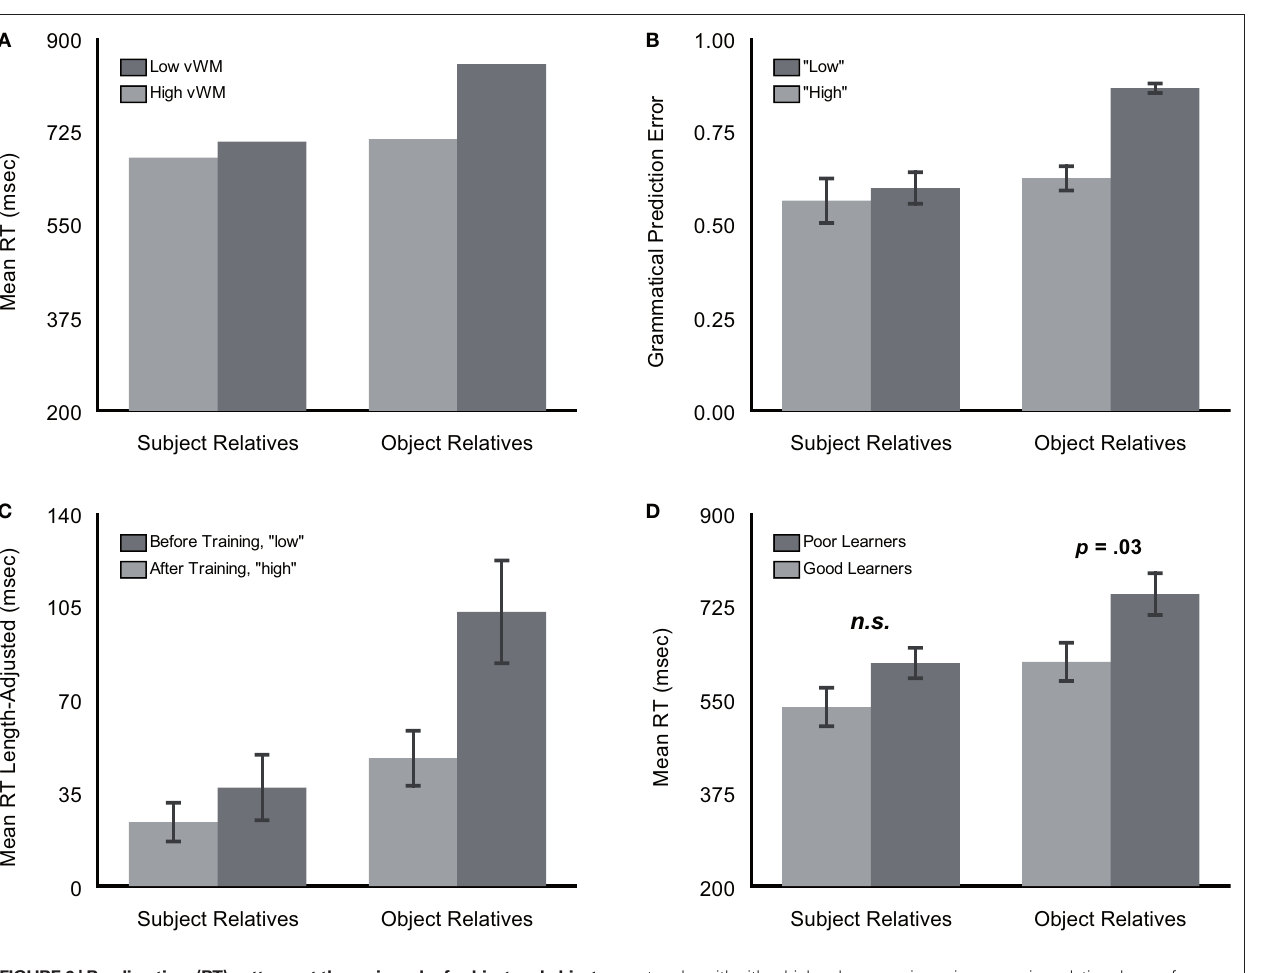
networks with either high or low experience in processing relative clauses from MacDonald and Christiansen (2002); (C) pre- and post-training length-adjusted RTs for individuals in a study manipulation that increased their reading experience with relative clauses from Wells et al. (2009); and (D) mean RTs of good and poor nonadjacency learners reported in Experiment 2 of the present